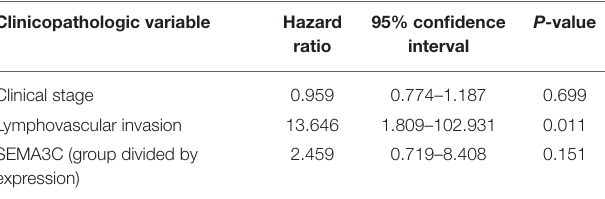
TABLE 3 | Multivariate Cox regression analysis of various prognostic parameters in the TCGA